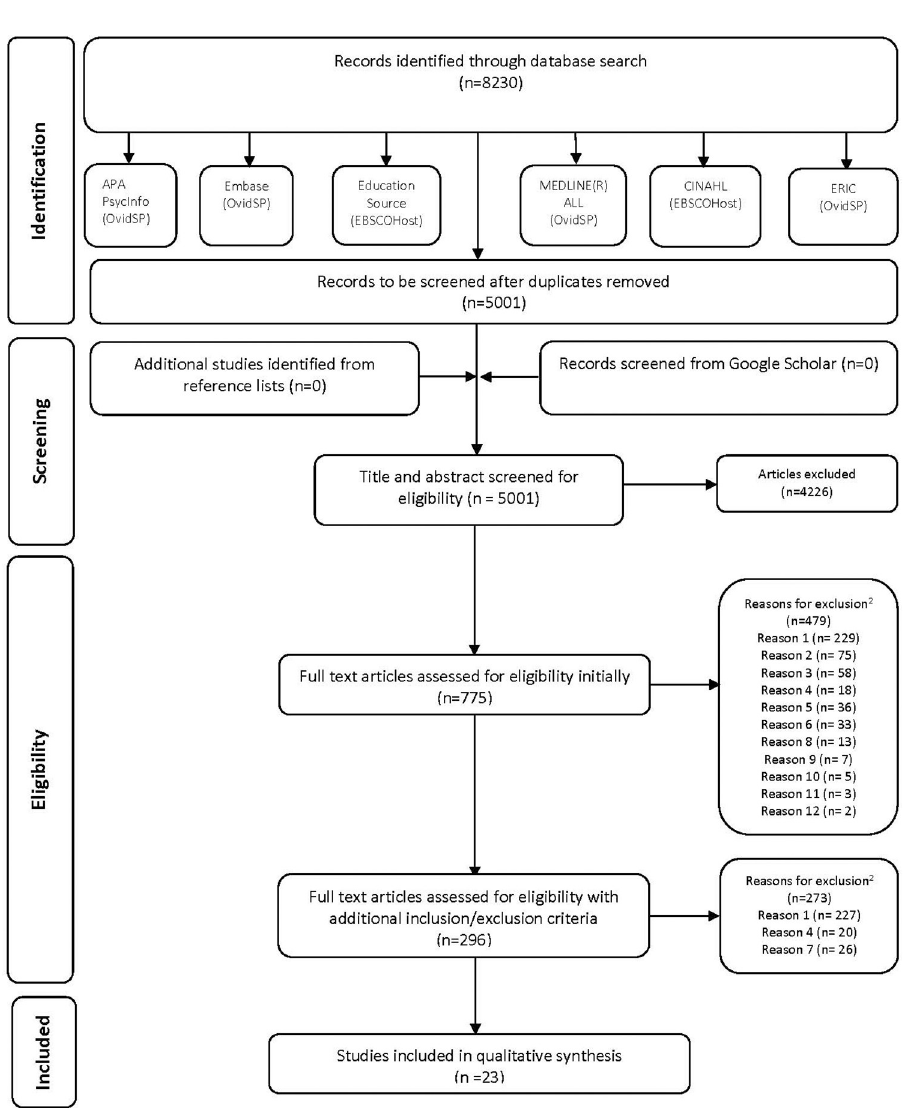
Fig 1. Flow diagram of literature search and selection